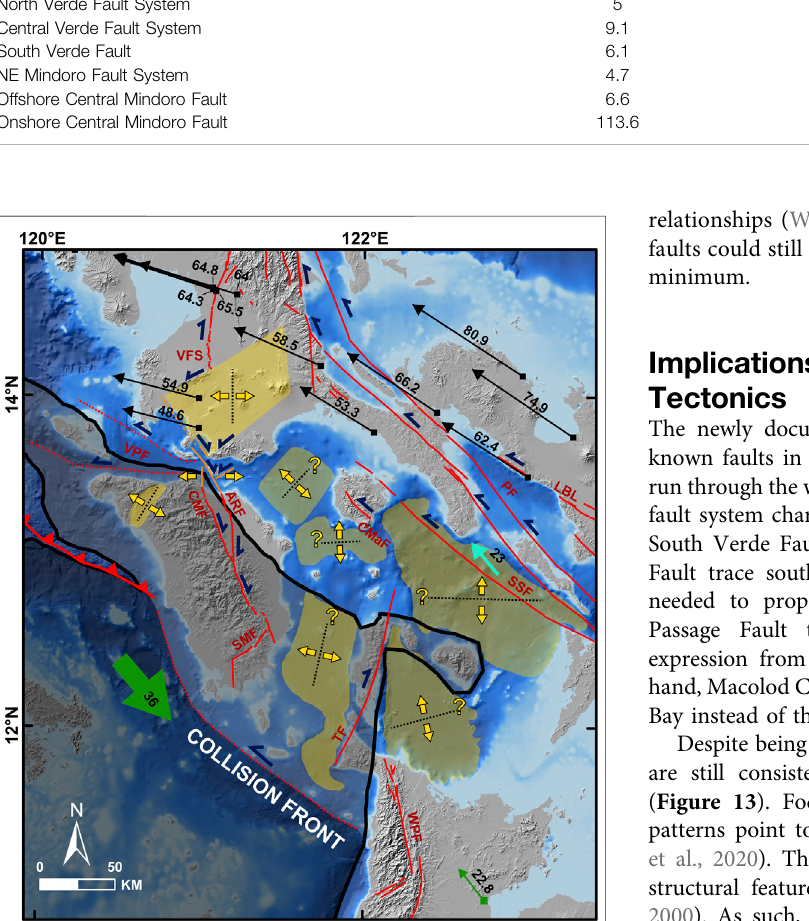
NorthPalawanBlockwhichiscurrentlycollidingwithPMB.Ontheotherhand, the PCB in a lighter shade is already emplaced in PMB and undergoing